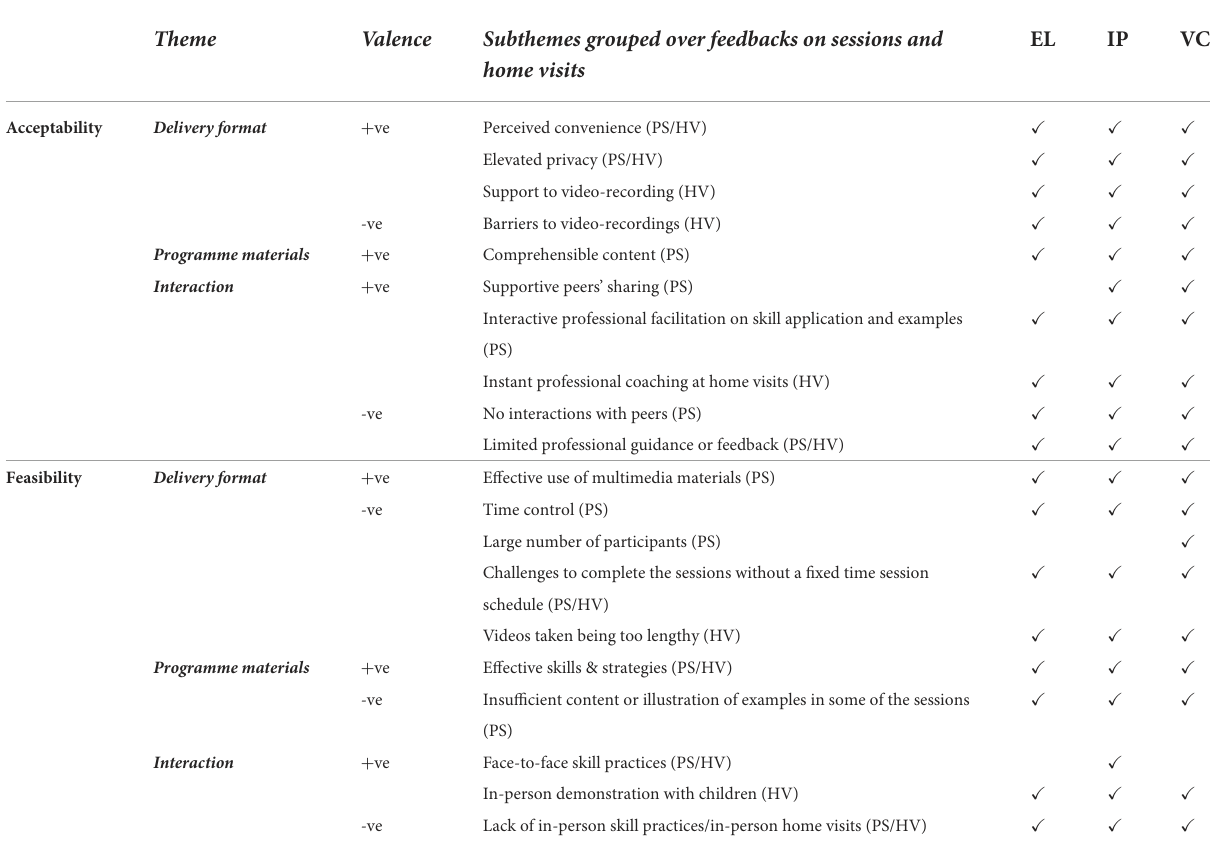
TABLE 9 Themes derived from comments of each Post-session & Home Visit.